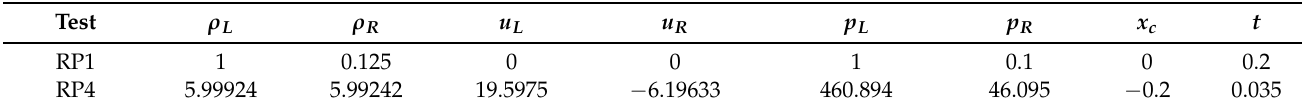
Table 4. Initial states left and right, initial position of the discontinuity x c , and final simulation time t for each Riemann problem.